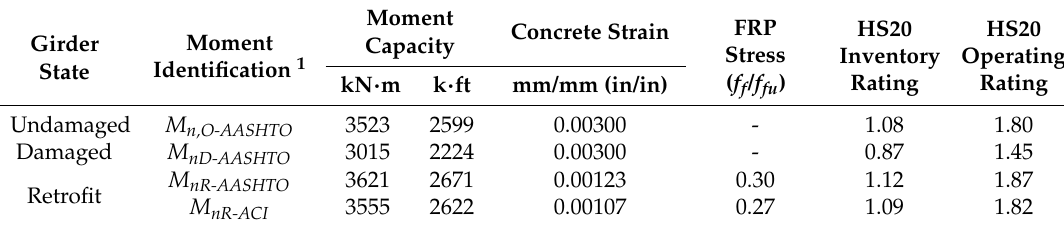
Table 2. RC girder capacity at different stages of retrofit.